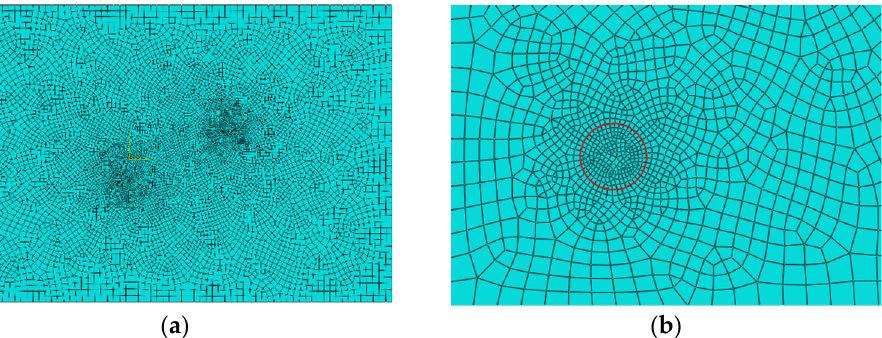
Figure 2. Grid division. Red circle in ( b ) represents a frozen well. ( a ) Overall division; ( b ) Division around frozen well.